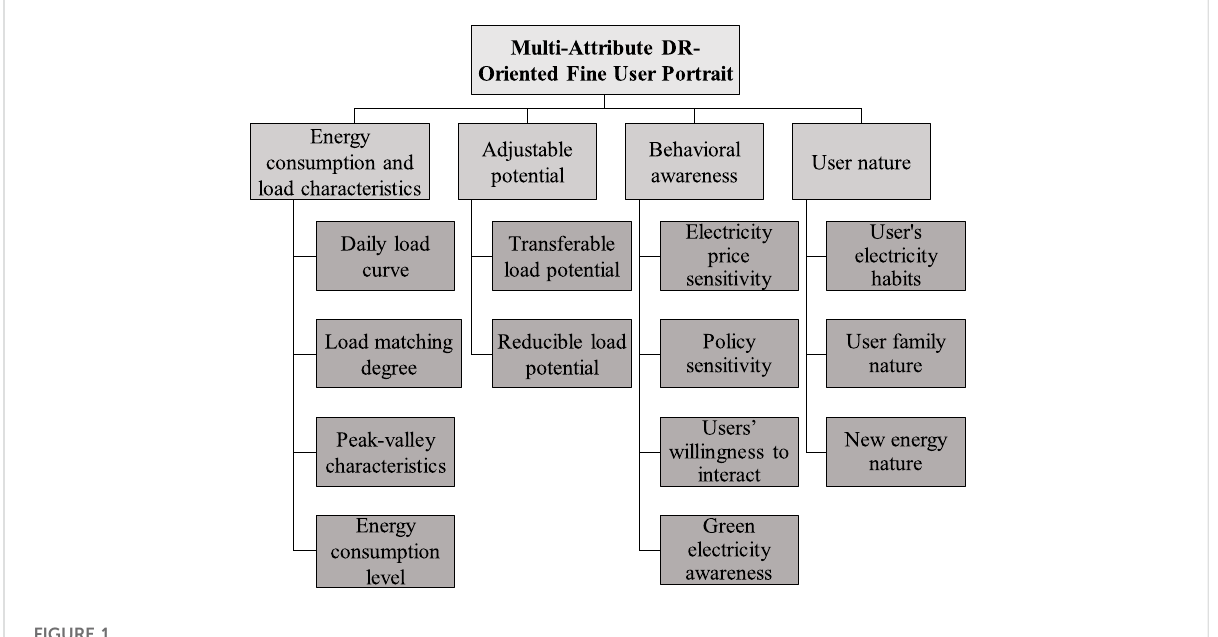
FIGURE 1 Multi-attribute evaluation index system for DR-oriented user